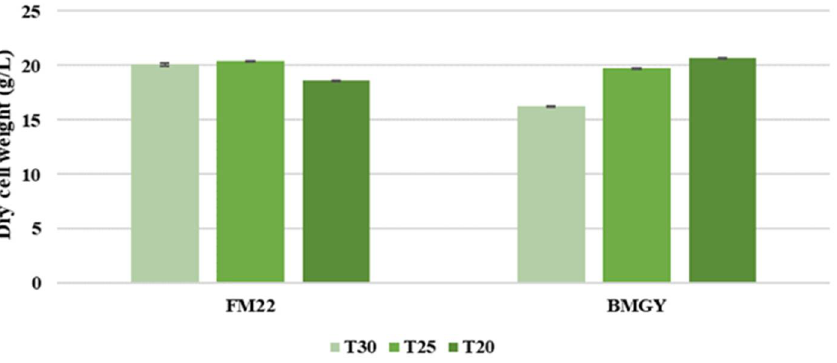
Figure 5. Dry cell weight comparison of P. pastoris at temperatures 20, 25 and 30 °C when grown in FM22 and BMGY media with an induction pH of 6.0.